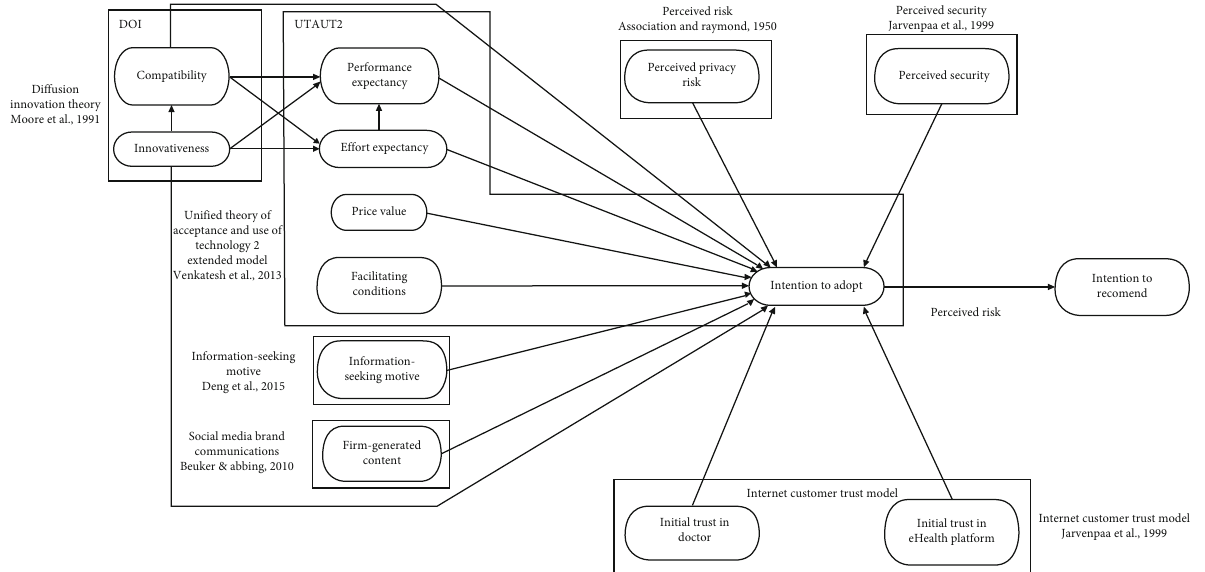
Figure 1: The research model. DOI: di ff usion of innovation; UTAUT2: an extended uni fi ed theory of acceptance and use of technology; SMBCT: social media brand communication